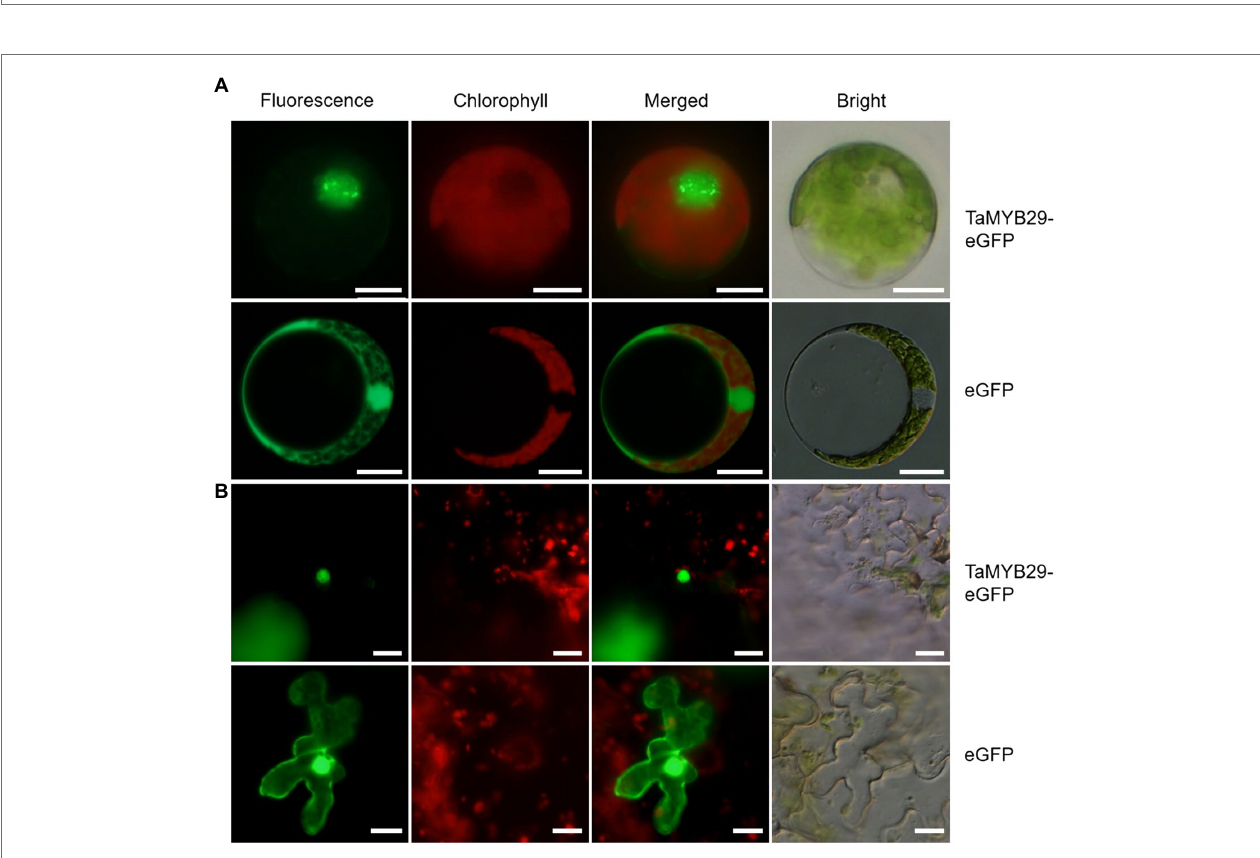
FIGURE 1 | Alignment of the amino acid sequence of TaMYB29 with its homologous sequences. The sequences were aligned with DNAMAN. The identical residues are shaded. The black arrow line shows the MYB-binding domain. The asterisks ( ∗ ) show typical R2R3-MYB protein contains three regularly spaced tryptophan (W) residues and the first tryptophan residue was replaced by phenylalanine (F) in the R3